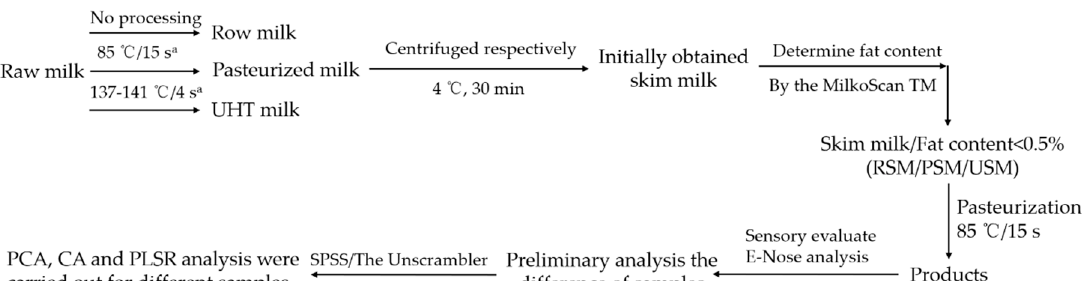
Figure 7. Flow diagram of the preparation and flavor quality analysis of skim milk. (a, Industrialized pasteurization and ultra-high temperature (UHT) sterilization conditions from Beijing Sanyuan Food Corp., Ltd. (Beijing, China)).